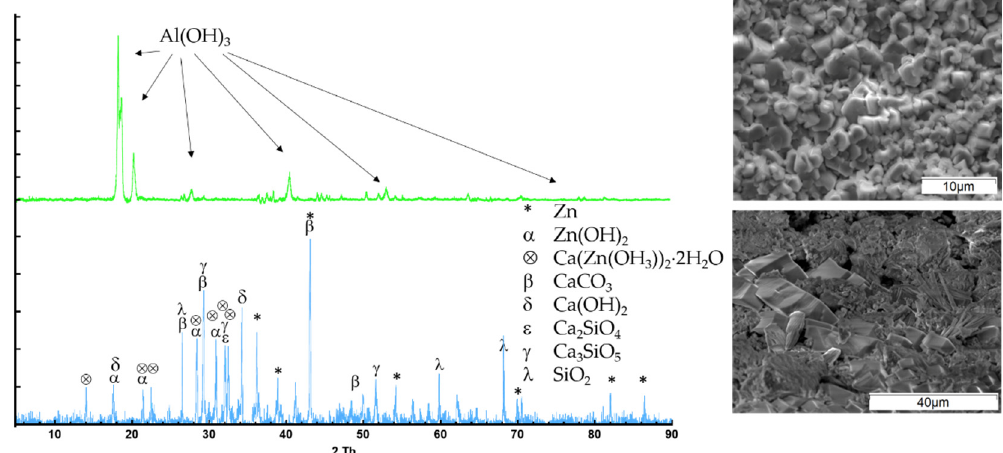
Figure 7. Corrosion product morphology by means of XRD diffractograms and SEM images for Al (top) and Zn (bottom) embedded in concrete immersed in AGW at anaerobic conditions for 1 year.